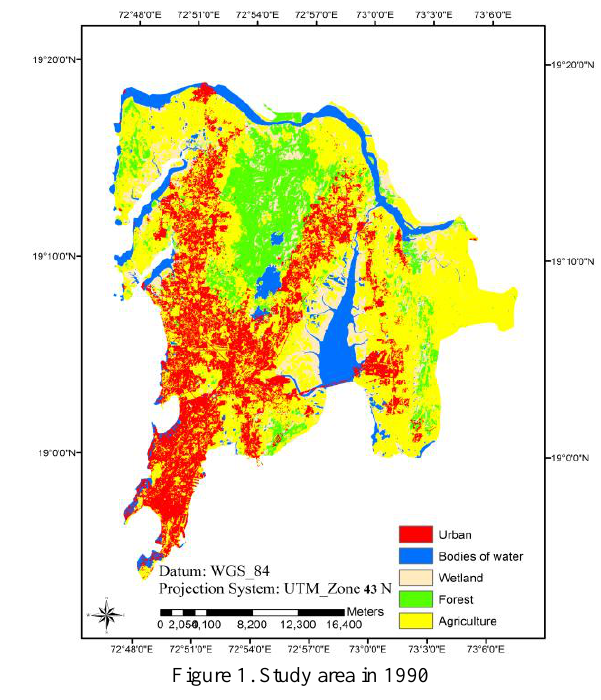
Figure 1. Study area in